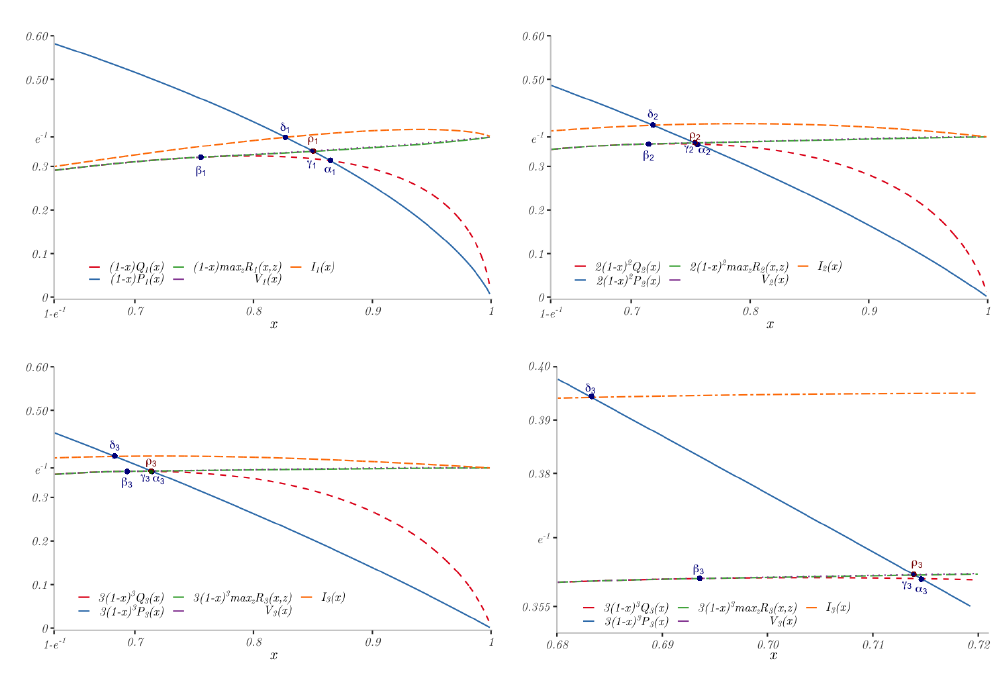
Figure 5. Stop, continuation, z-strategy values and bounds; k = 1,2,3 and zoomed-in view for k = 3.